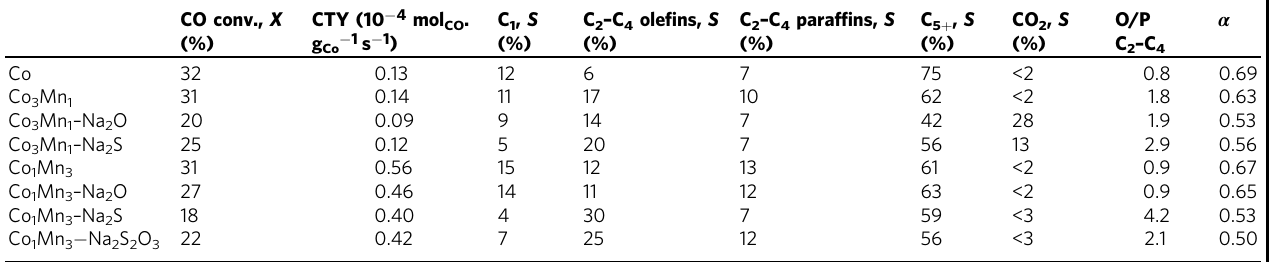
Table 1 Catalytic performance at 240 °C, 10 bar, H 2 /CO = 2, 18 – 30% CO conversion CO conv., X